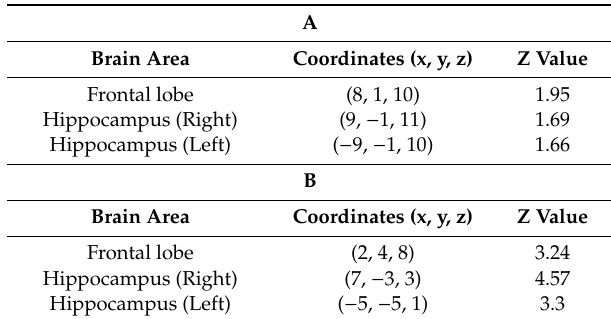
Table 1. The changes of Z values in the hippocampus and frontal lobe. The results of voxel-wise comparison between the TMT + Bean-PS and TMT group datasets are shown (Table 1A). In the statistical parametric mapping (SPM) analysis, the cerebral glucose uptake of TMT + Bean-PS datasets was significantly increased in the hippocampus and frontal lobe compared with that of the TMT group (Table